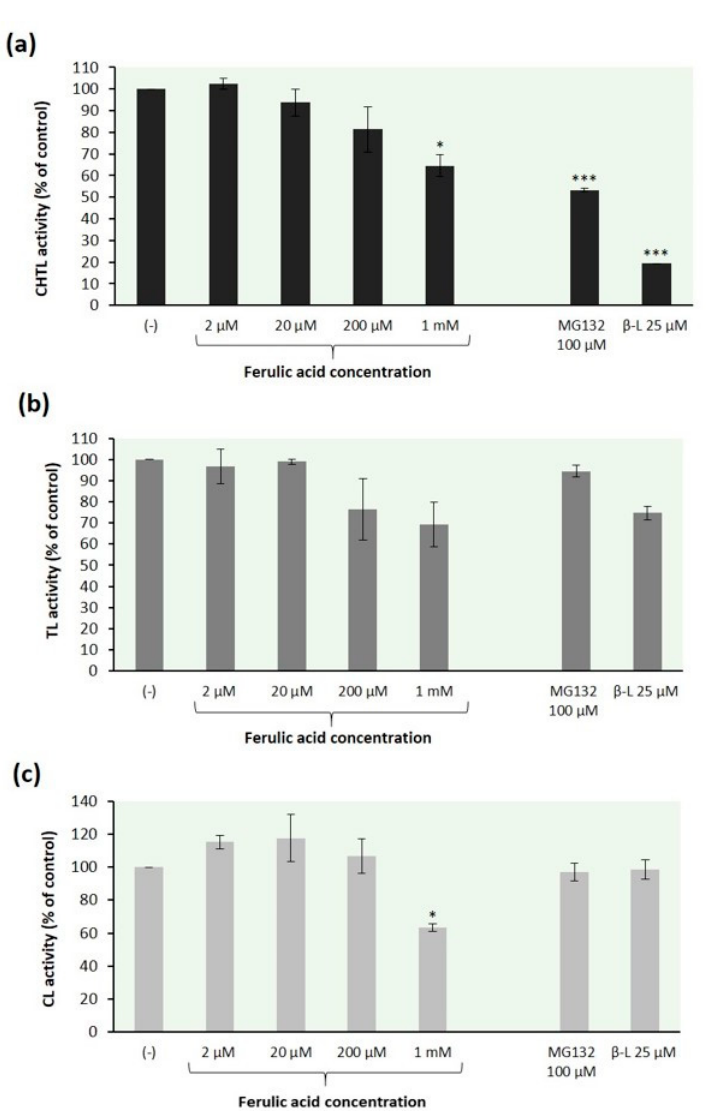
Figure 2. Effect of ferulic acid on peptidase activities of the 26S fungal proteasomes: ( a ) chymotrypsin-like (CHTL), ( b ) trypsin-like (TL), and ( c ) caspase-like (CL) activity. The 26S proteasomes were obtained from T. versicolor mycelial extracts using a 5-step separation procedure with 500 kDa cut-o ff membranes. Reaction mixtures containing the proteasome solution were preincubated with ferulic acid at various concentrations for 30 min before the addition of the fluorogenic peptide substrates: Suc-LLVY-AMC, Z-GGR-AMC and Z-LLE-AMC for measuring CHTL, TL, and CL activity, respectively. Proteasome inhibitors MG132 and clasto-lactacystin β -lactone ( β -L) were used as comparison with ferulic acid. The specific activity (nanomoles of AMC per mg of protein) of samples with the DMSO solvent alone was taken to be 100%. The data represent means ± SD of three independent experiments performed in duplicate (* p < 0.05, ** p < 0.01, and *** p < 0.001).